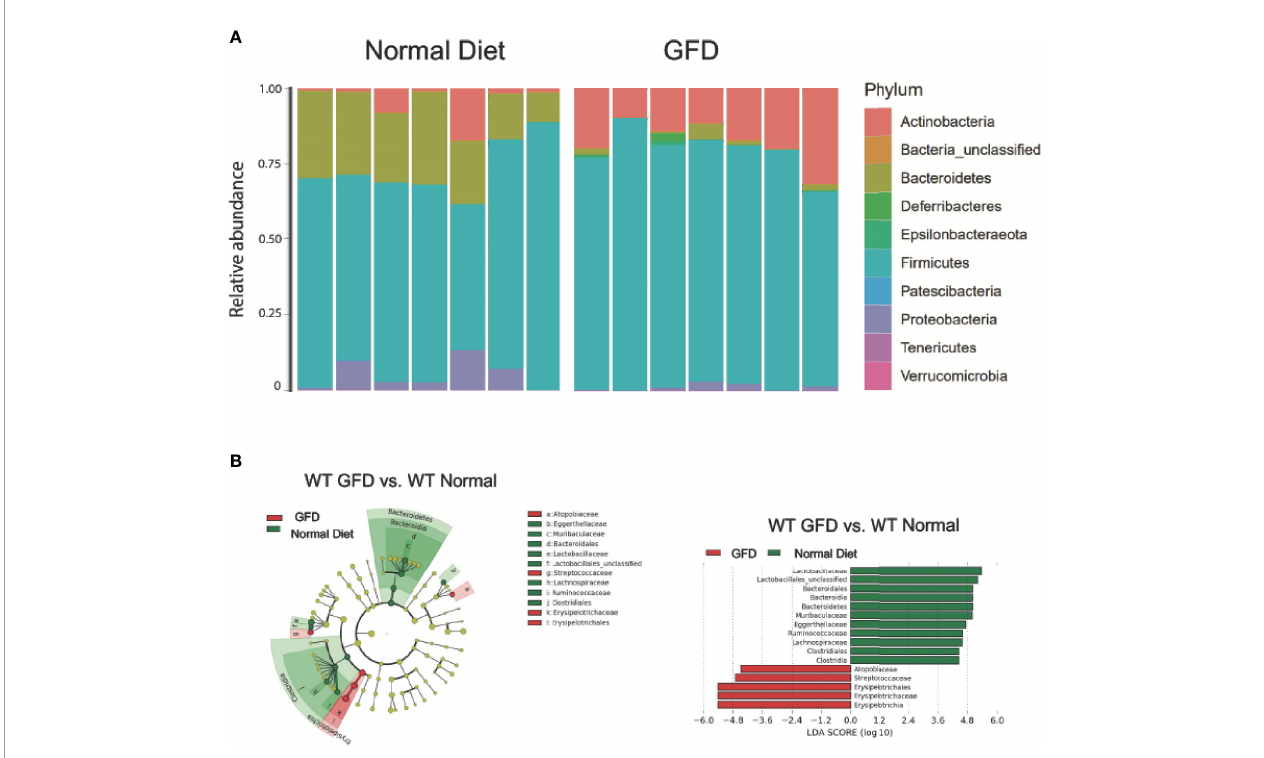
FIGURE 3 | Mice with Intact NLR Signaling Display a Distinctive Microbiome Depending on Diet-type. (A) The microbiomes of mice with intact NLR signaling are dominated by the Firmicutes phyla. The second most abundant phyla is driven by diet type with normal diet being characterized by Bacteroidetes and GFD by Actinobacteria. (B) LEfSe differential analysis displaying LDA scores reveals that signi fi cant differences exist between the microbial populations (GFD, red and normal diet, green. The graph was generated using the LEfSe program. GFD (red), n = 7 ; normal diet (green), n =